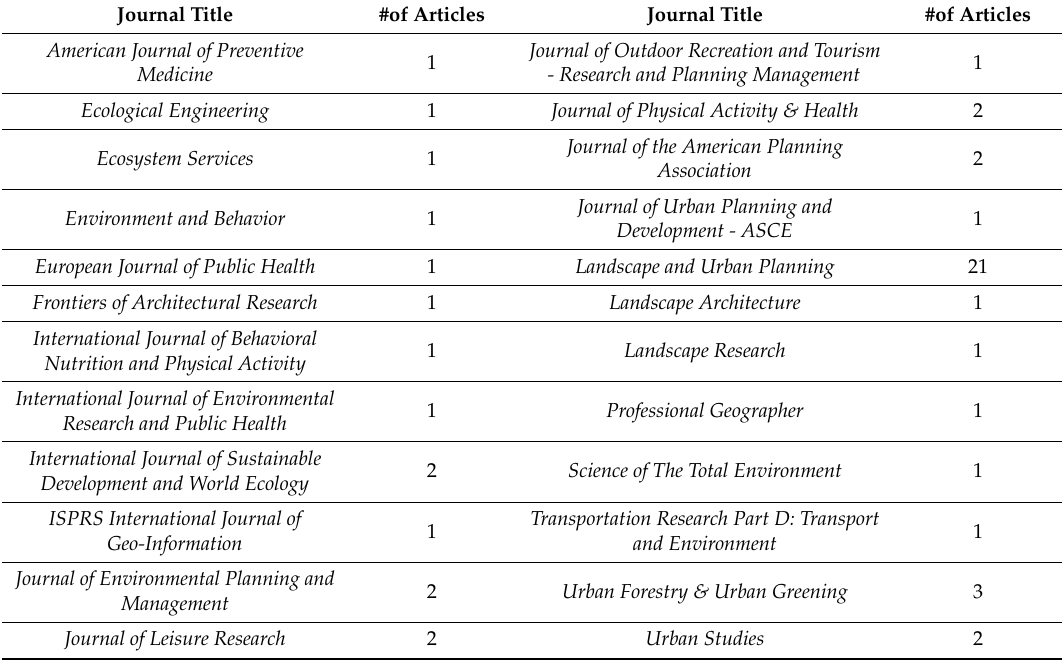
Table 2. Number of articles per journal.